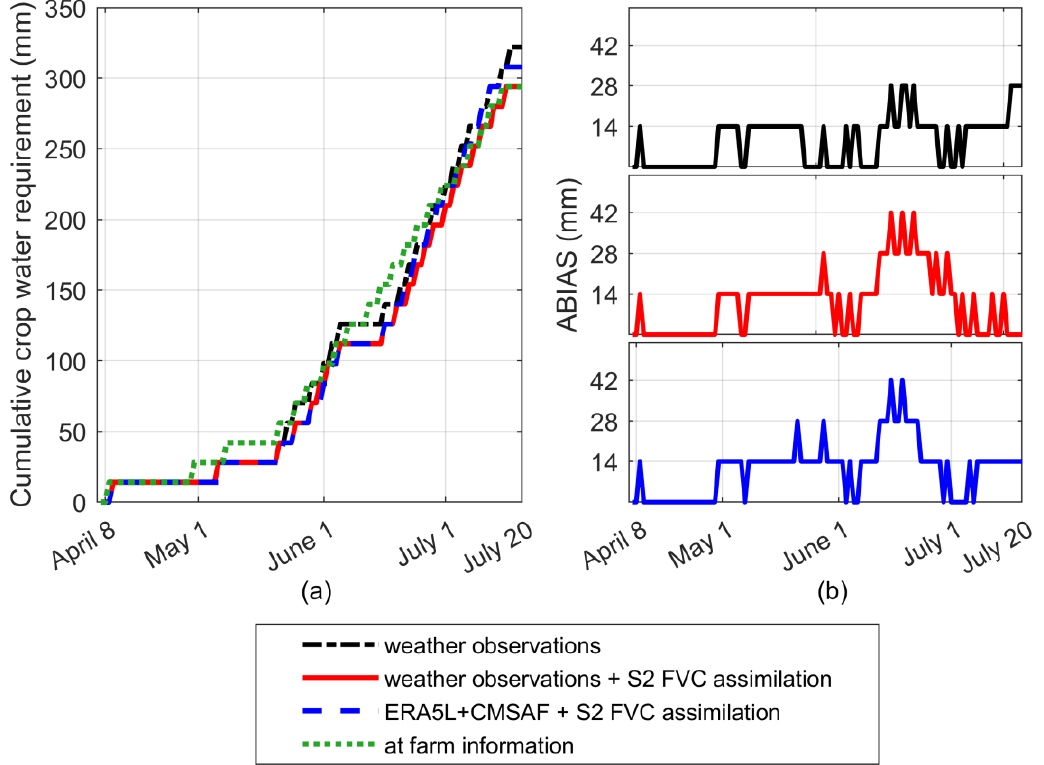
Figure 9. ( a ) Cumulative irrigation depth for different model inputs, as described in the legend, compared with the “at farm” irrigation depth; ( b ) Cumulative ABIAS (mm) of the cumulative irri- gation depth for different model inputs, assuming the “at fa r m” irrigation depth to be a benchmark.